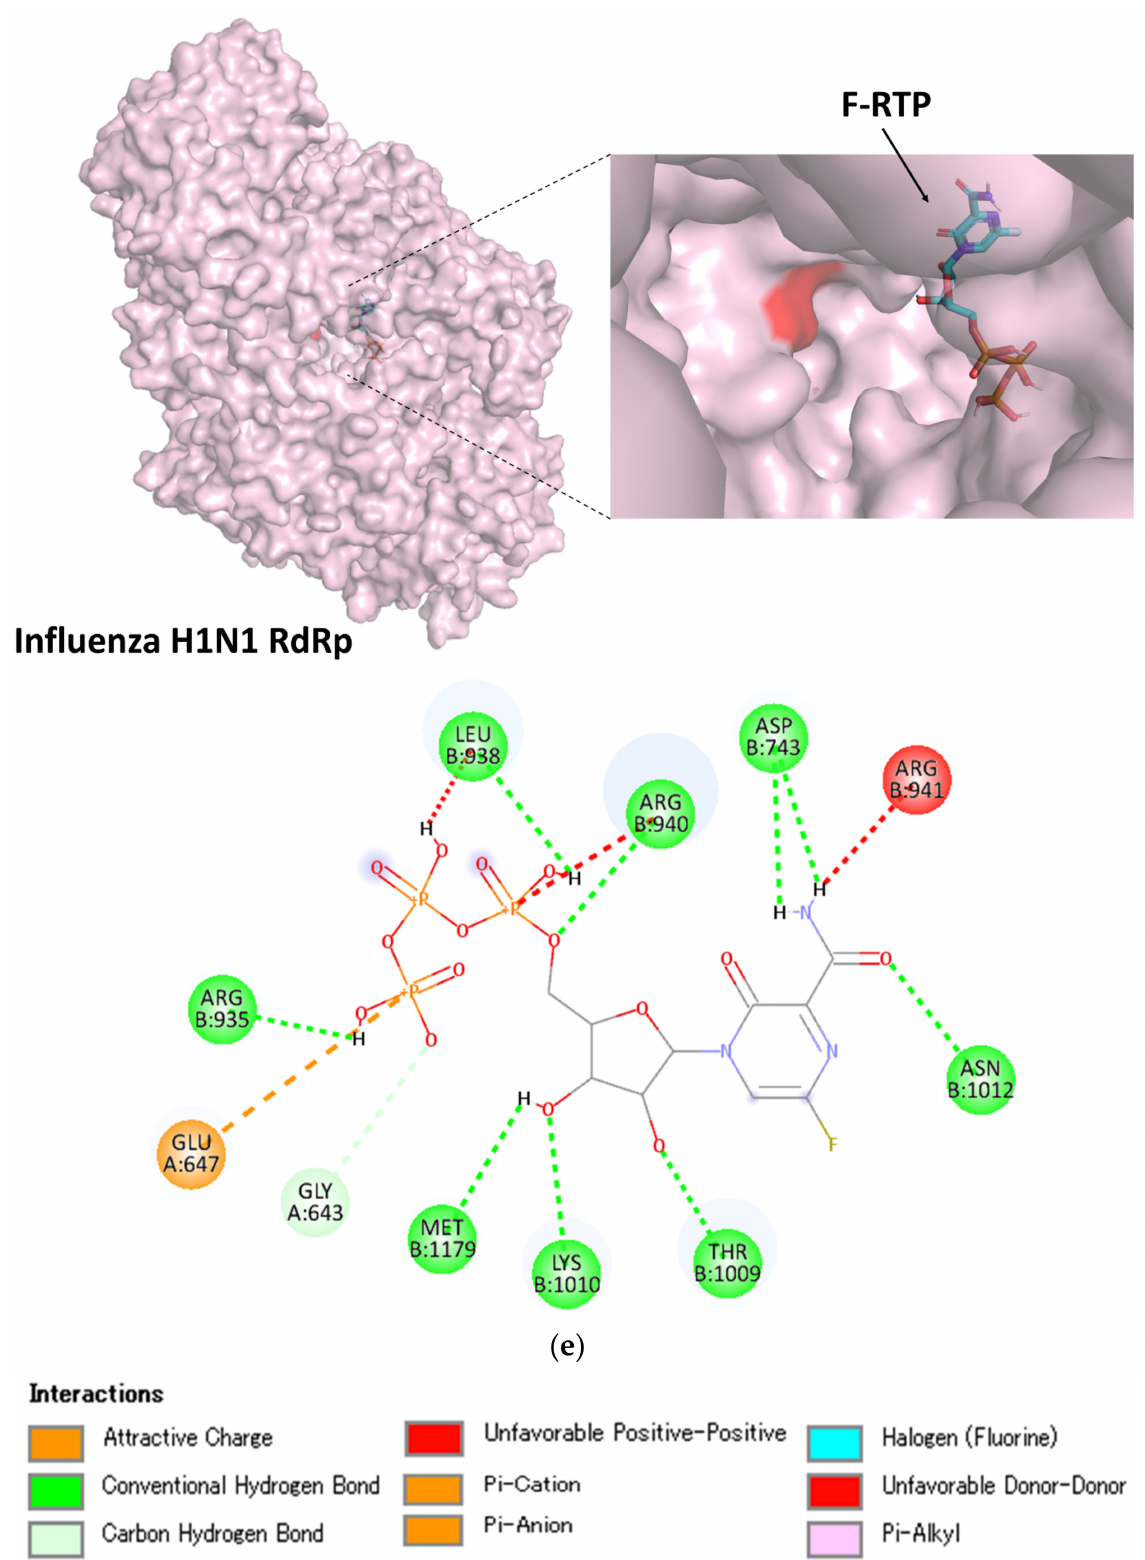
Figure 2. Diagram illustrating the binding conformations and interactions of favipiravir ribofuranosyl- 5 (cid:48) -triphosphate (F-RTP) with ( a ) human metapneumovirus (HMPV) RNA-dependent RNA poly- merase (RdRp), ( b ) respiratory syncytial virus (RSV) RdRp, ( c ) mumps virus (MuV) RdRp, ( d ) measles virus (MeV) RdRp, and ( e ) influenza H1N1 RdRp. The red color on the surface of various proteins indicates active